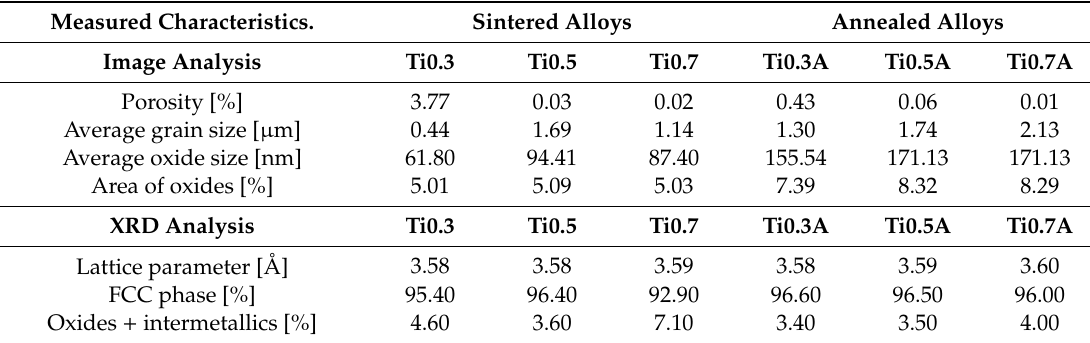
Table 3. Various measured characteristics of Tix alloys in sintered and annealed state measured by Image and XRD